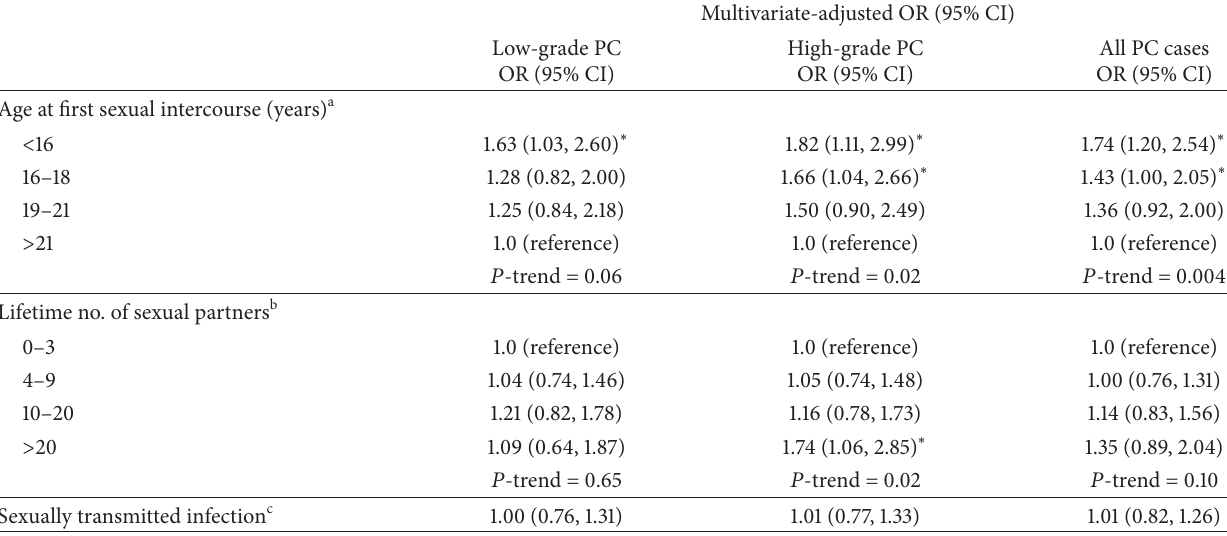
Table 3: Association between prostate cancer grade and sexual